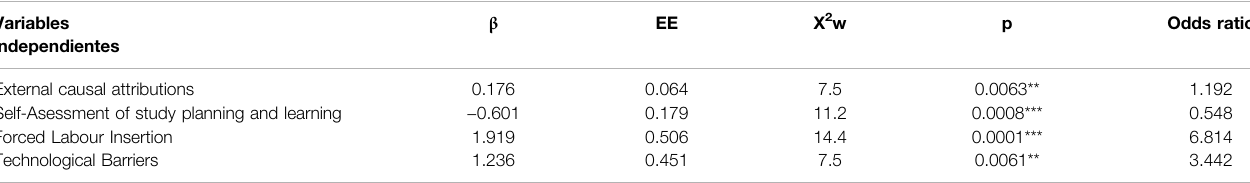
TABLE 5 | Signi fi cance of the variables for the model.